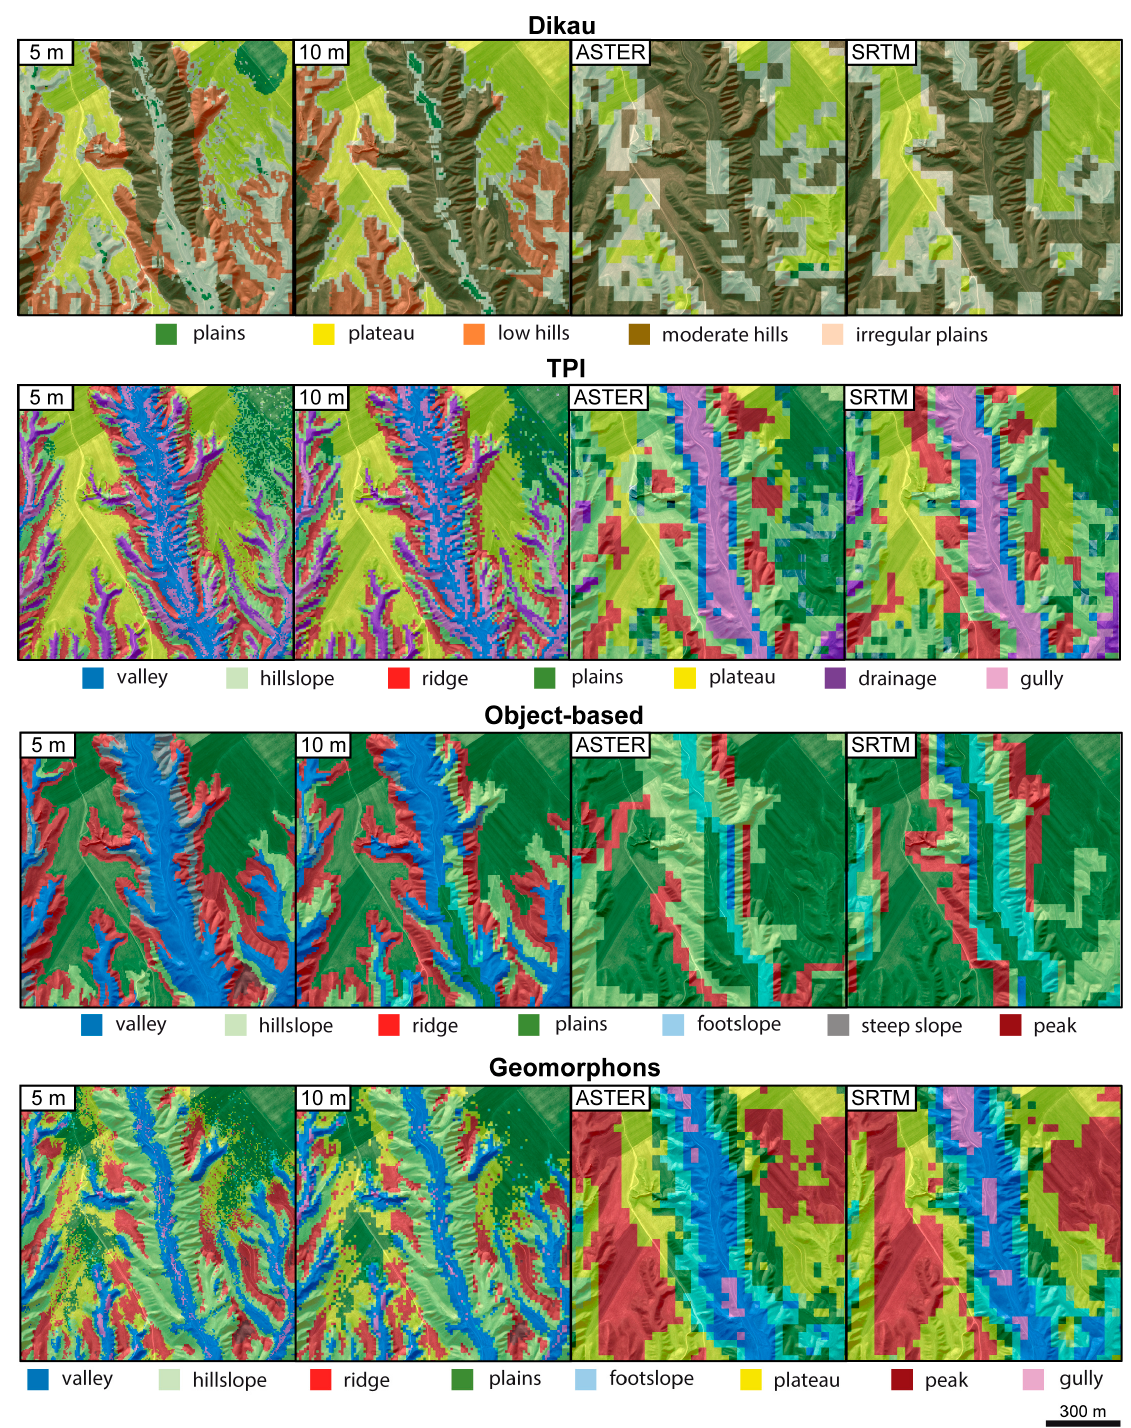
Figure 4. Comparison of a selected area, similar to Figure 2, for all approaches and different pixel resolutions. Background image: Pléiades satellite imagery © CNES (2015), Distribution Airbus DS.